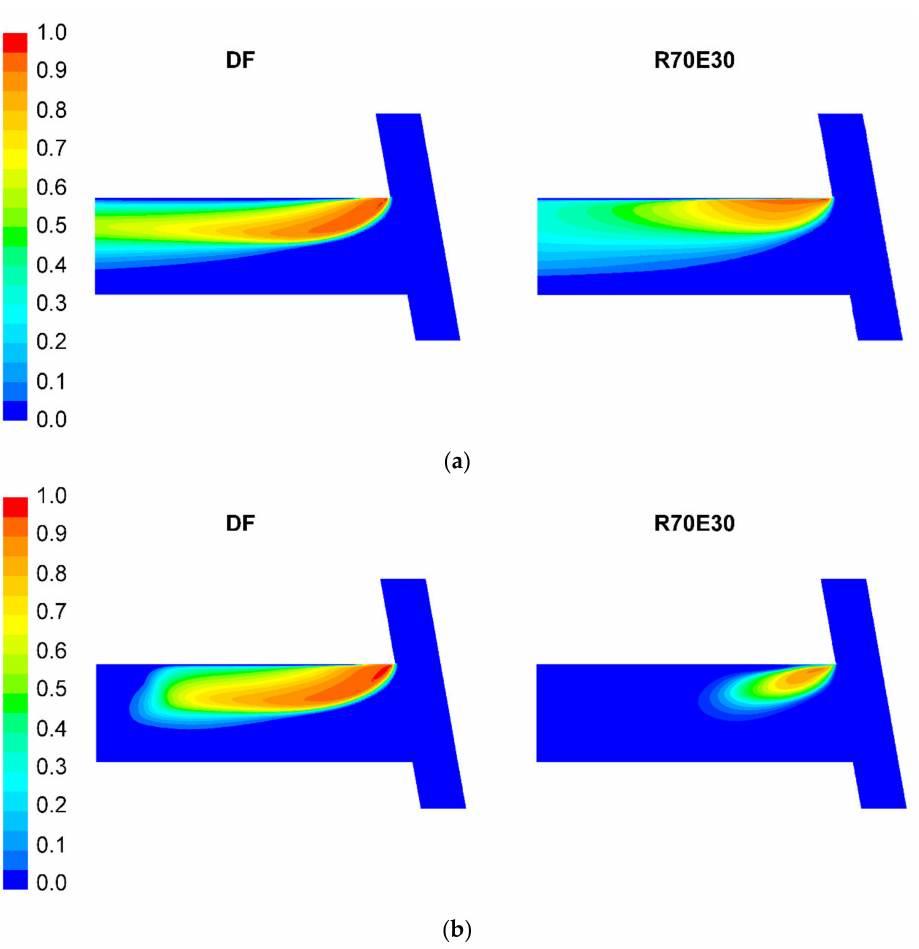
Figure 13. Distribution of VF of fuel vapors in the longitudinal section of the nozzle hole at two backpressures: ( a )—0.1 MPa; ( b )—8.9